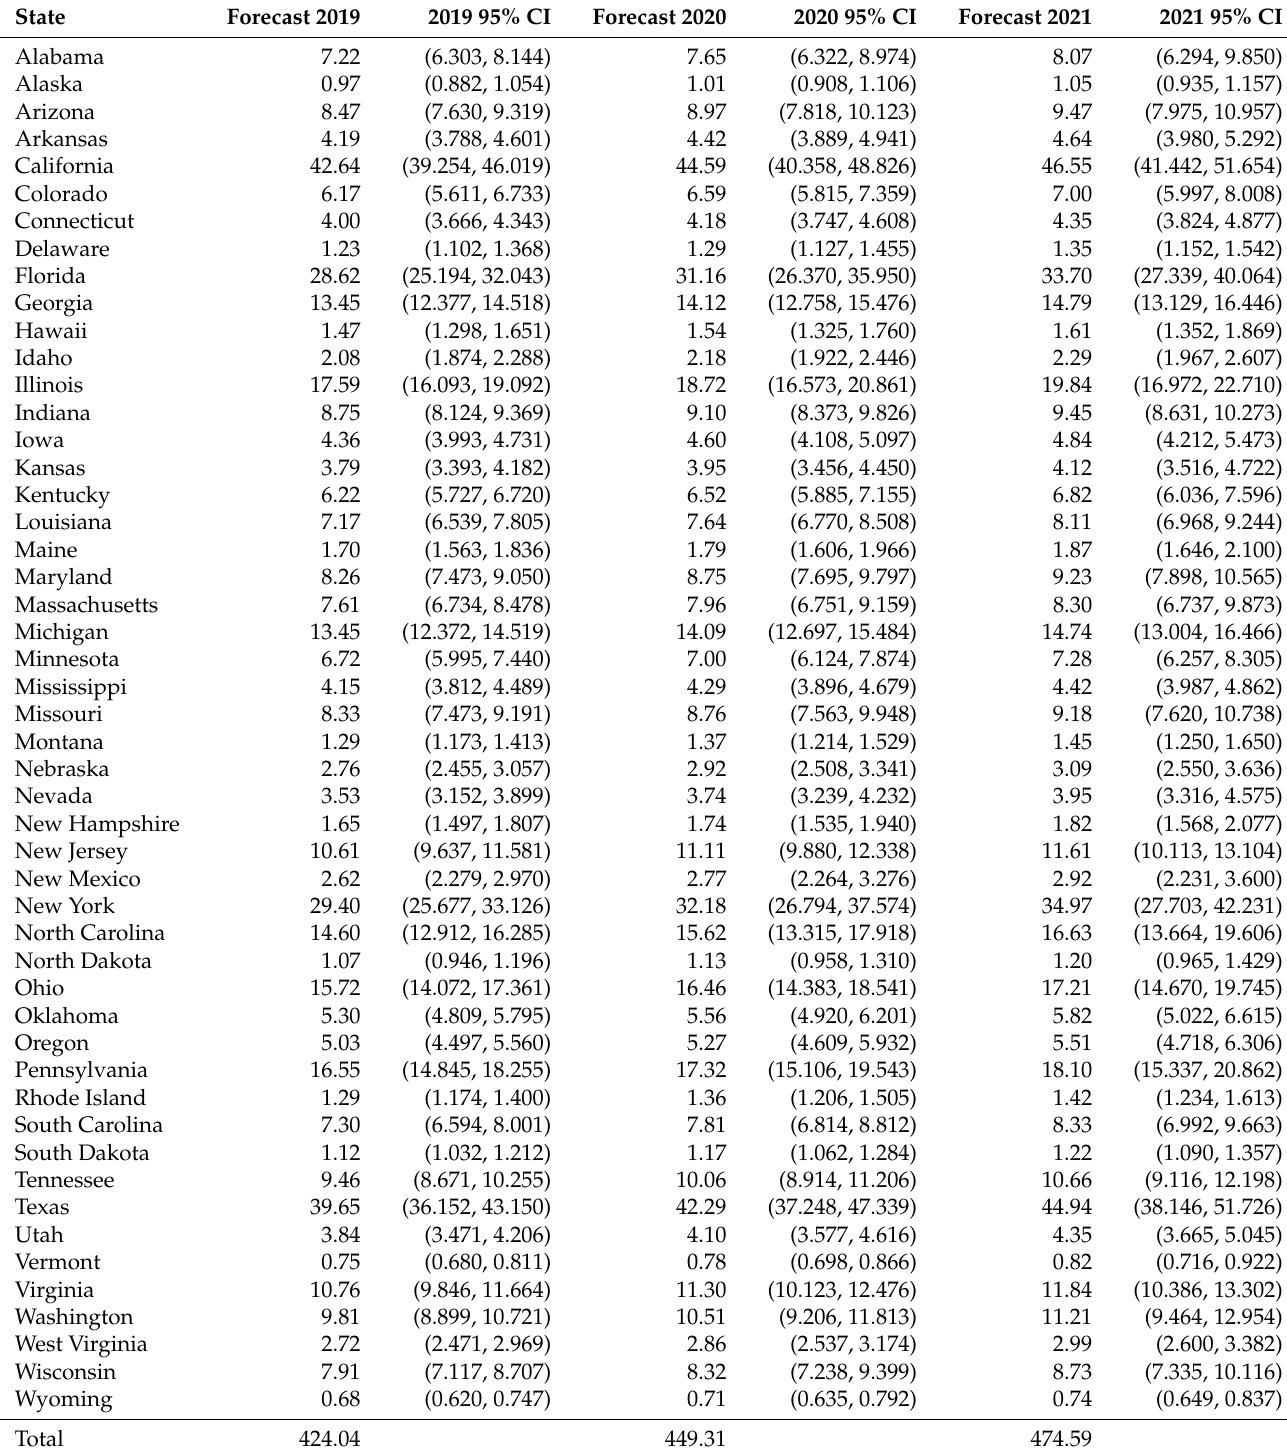
Table 6. Summary of the forecast by state for 2019, 2020, and 2021 with their corresponding 95% prediction intervals. All costs are expressed in the value of 2018 billions of